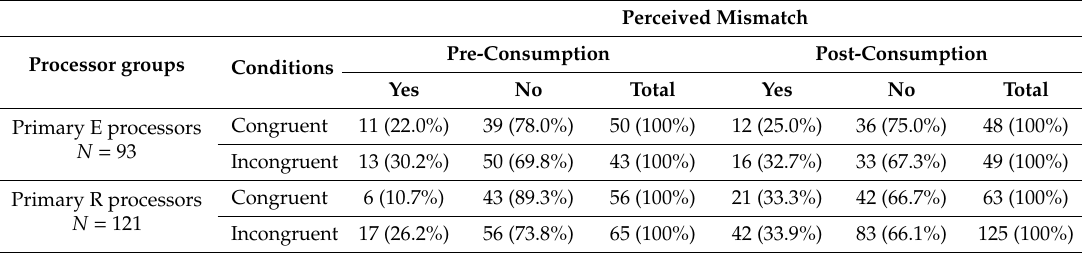
Table 6. Count and proportions (%) of perceived mismatch amongst (in)congruent conditions in pre- and post-consumption evaluation for primary E processors and primary R